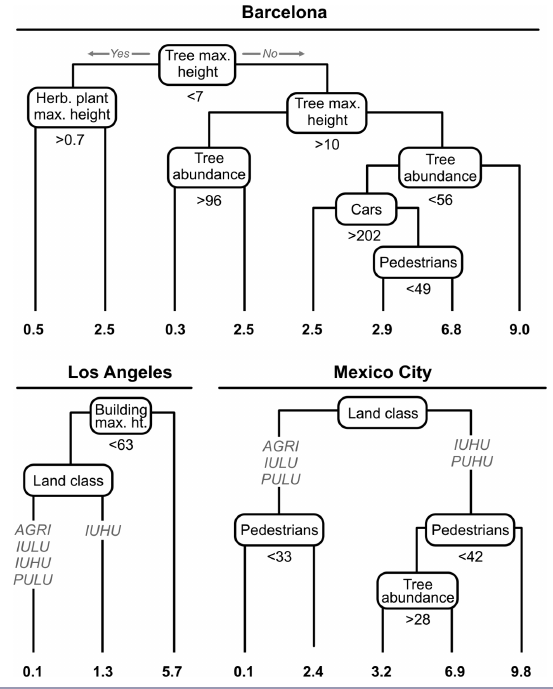
Fig. 4 . Classification and regression trees (CART) show the relationships between House Sparrow ( Passer domesticus ) abundances per point-count and eight predictor environmental variables as well as “land class.” Analysis of variance successively splits the dataset based on predictor variables that best explain the variability of the response variable (critical threshold values of each such variable are located below each tree split): subsets with mean values of the response variable corresponding to the marked threshold are placed: true on the left side and false on the right side. Given the nature of the relationships, some continuous variables may appear at multiple tree splits, even with different relationships.